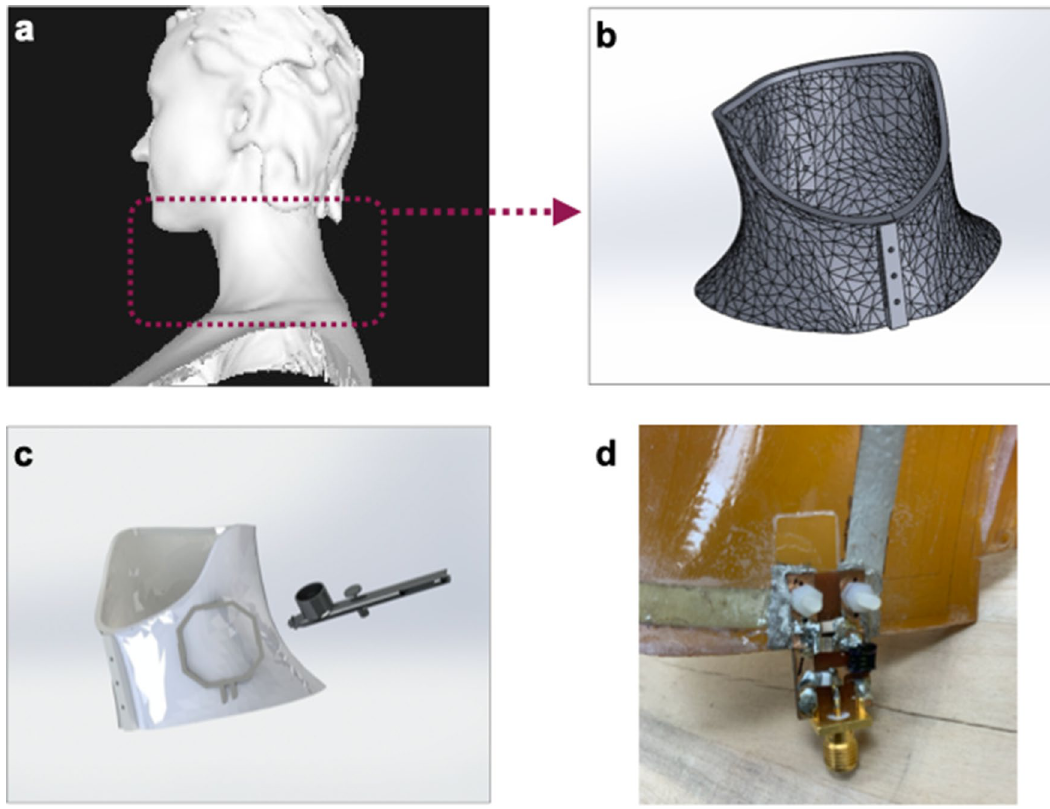
Figure 1. Manufacturing flow diagram for custom specific MRI receive cells. ( a ) A scan of the volunteer’s body part (neck) generated using a structural scanner. ( b ) CAD drawing generated using the structural scan to perfectly fit the volunteer’s neck and used to 3D-print a custom substrate. ( c ) Schematic representation of spray deposing coil components onto the 3D-printed custom substrate. ( d ) Q spoiling and matching circuitry connected to the coil with plastic screws and conductive